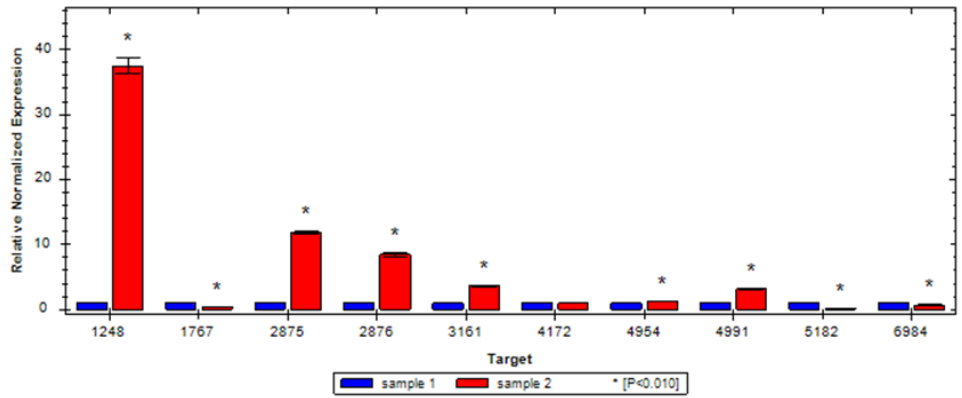
Figure 3. Validation of differentially expressed sRNAs. sample 1, control; sample 2, A. baumannii after exposure to subinhibitory minocycline.